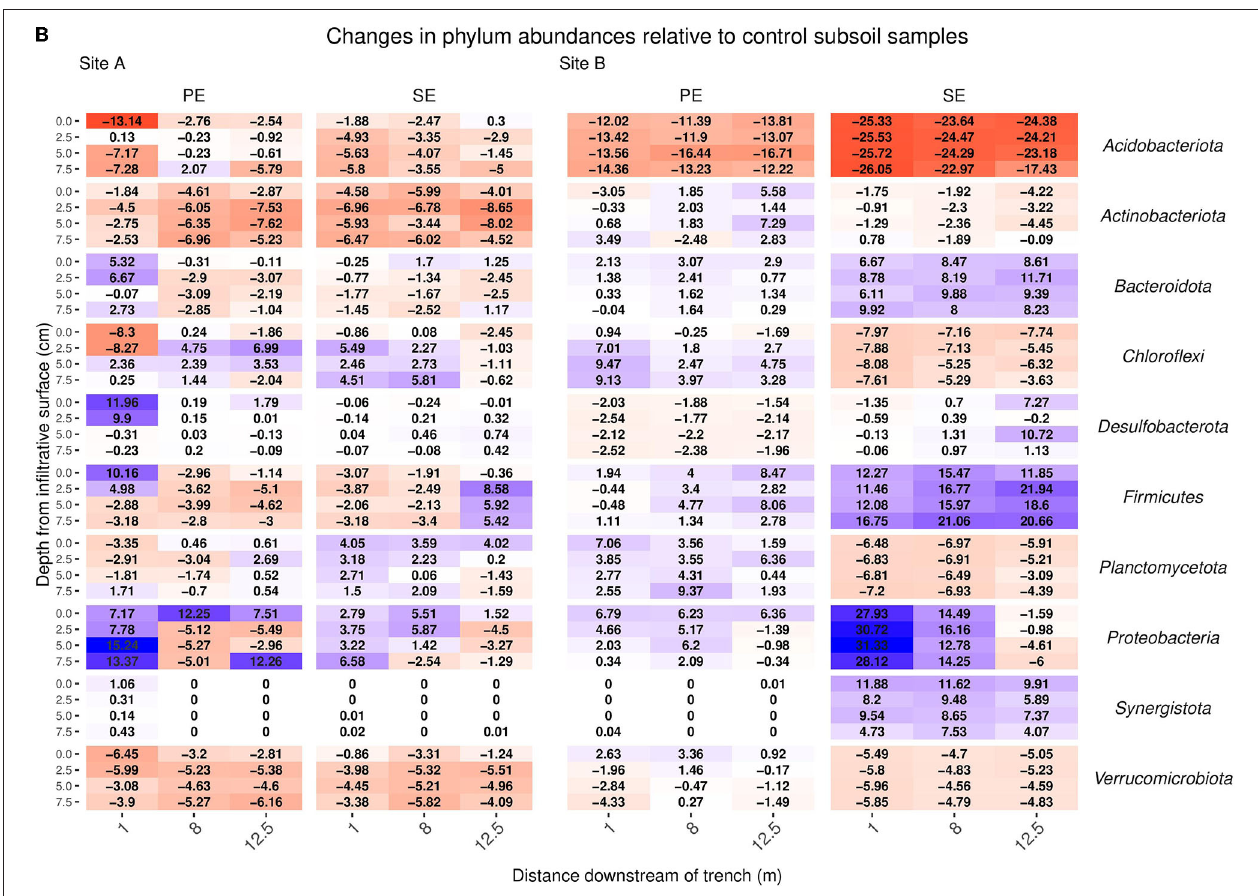
FIGURE 2 | (A) Mean ± SD of relative read abundance of phylum level analysis for Sites A and B for both the Primary (PE), secondary (SE), and control samples for each “system”: control; base (CB), top (CT), STU topsoil (TT), and STU subsoil “trench base” (TB). The STU base is further divided into proximal (P) at 1m, midpoint (m) at 5m, and distal (d) at 12m. (B) The changes of key phylum relative abundance relative to control subsoil communities, and increases are highlighted in blue and reductions in red.